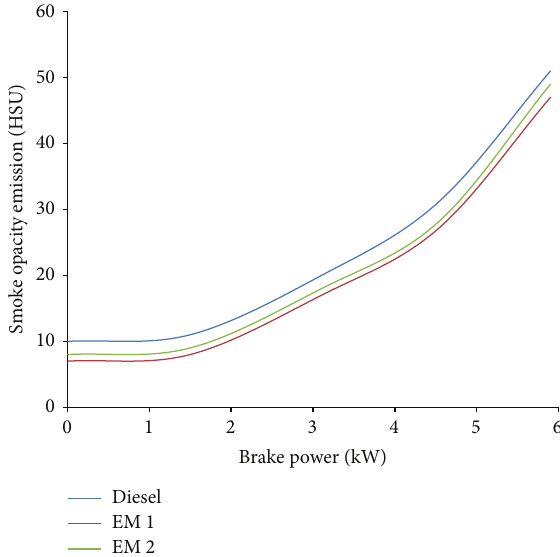
Figure 4: Brake power versus carbon monoxide (CO) emission.